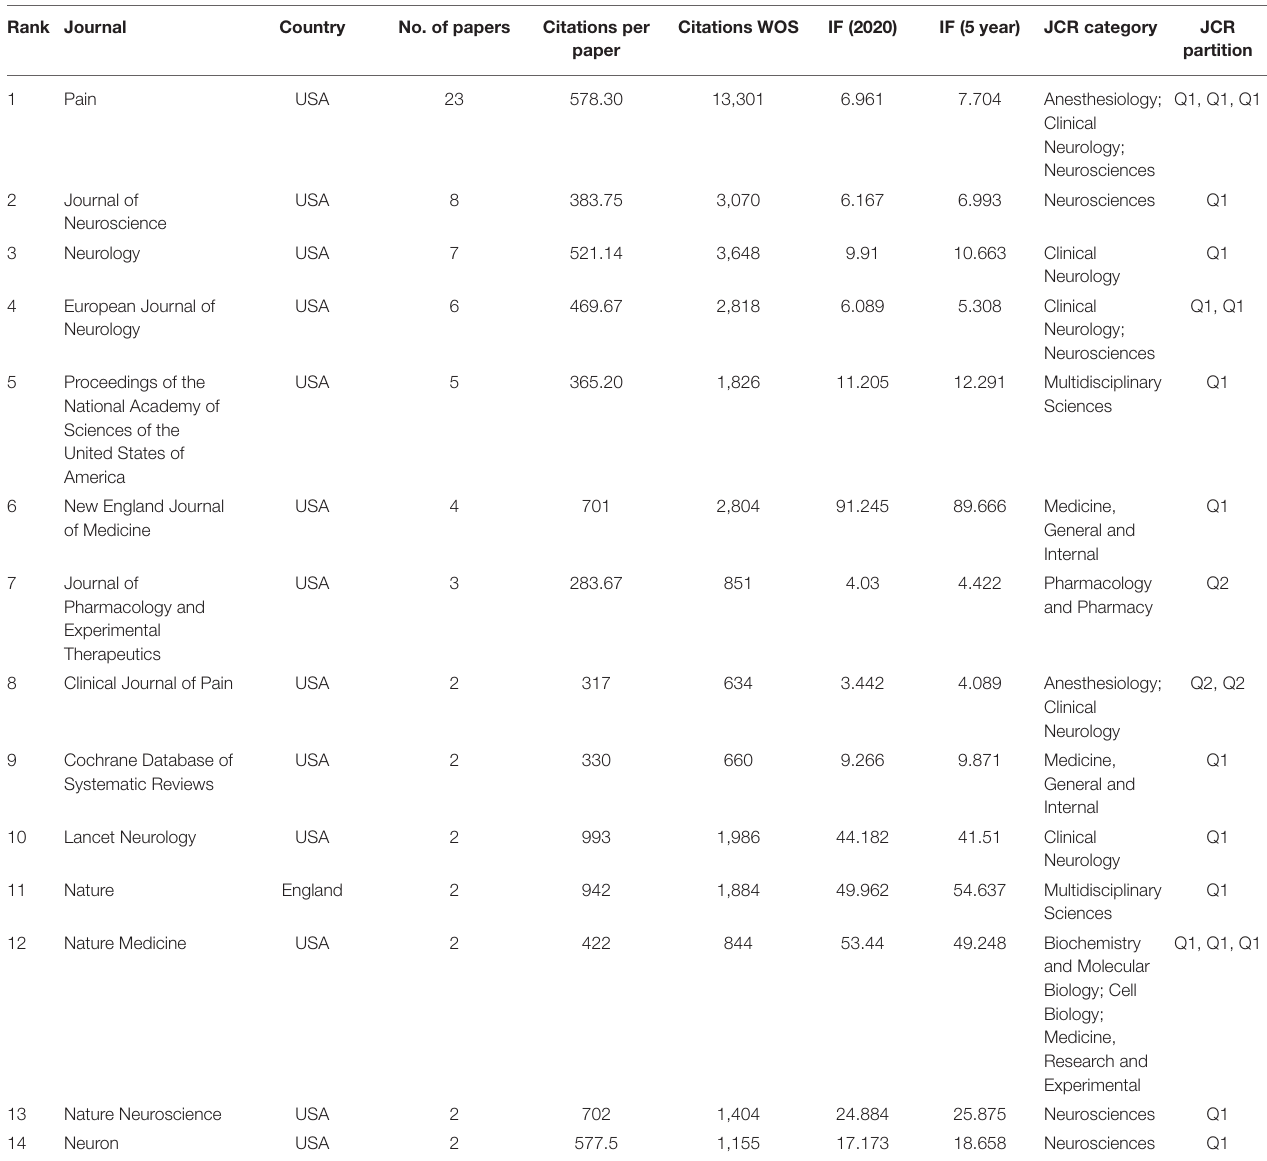
TABLE 3 | Journals contributed ≥ 2 papers in the top 100 most cited